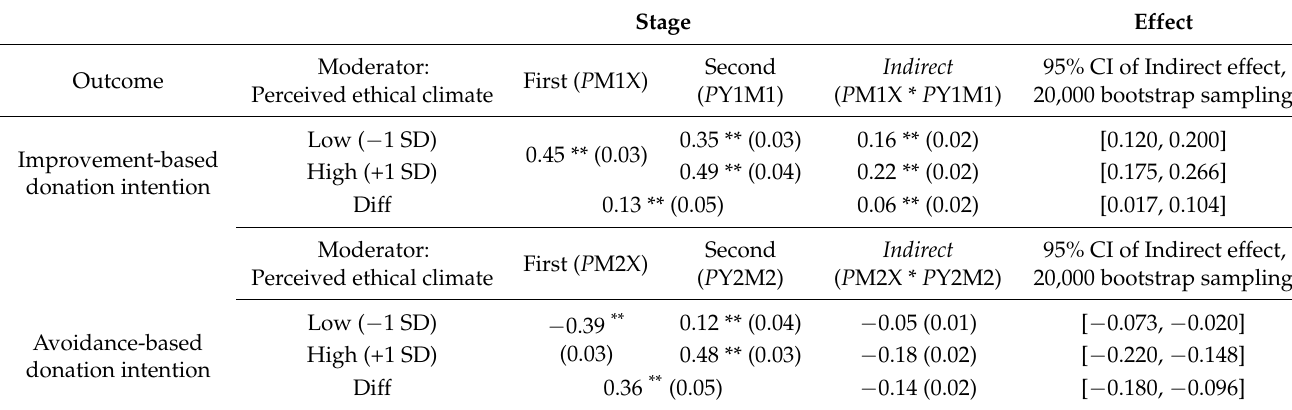
Table 3. Moderated mediation effect of perceived ethical climate. Stage